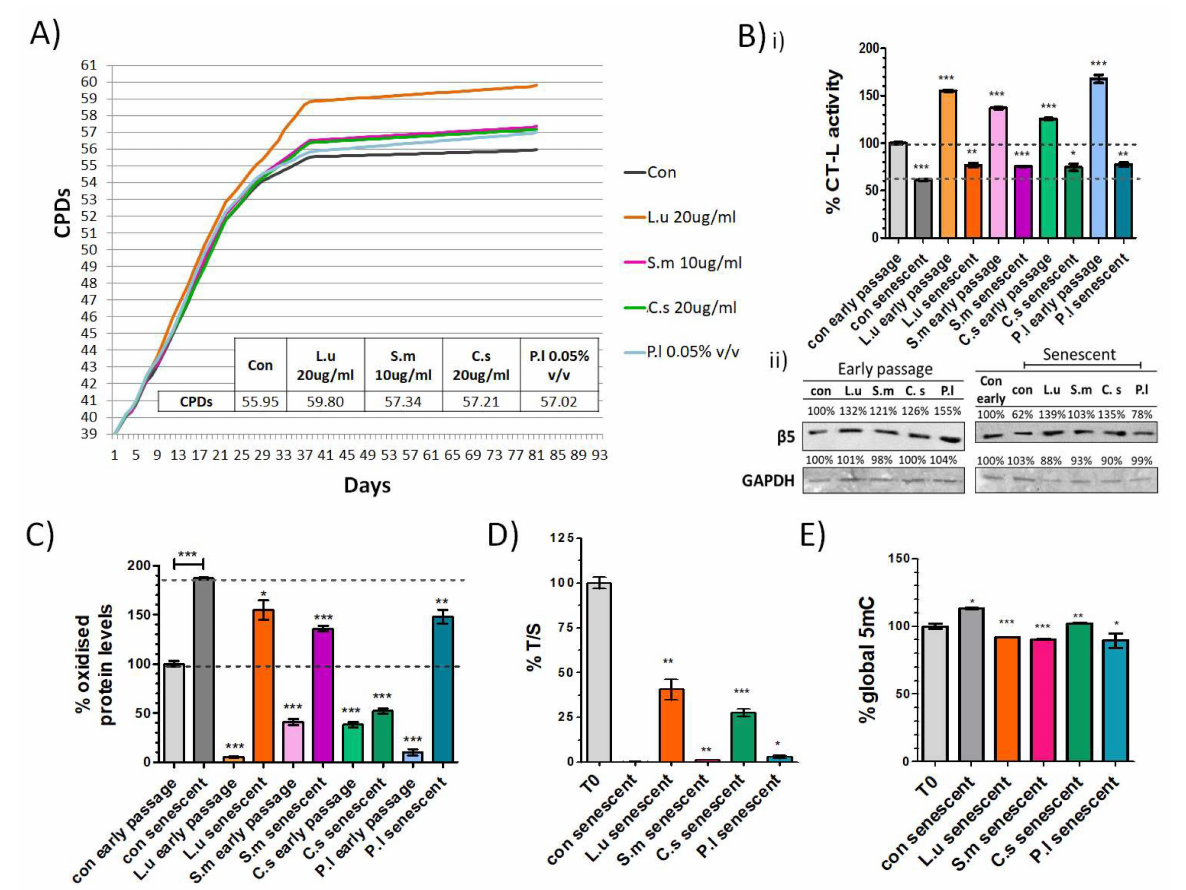
Figure 1. The formulation extends cellular replicative lifespan and reduces the manifestation of aging biomarkers. ( A ) Number of cumulative population doublings (CPDs) of human embryonic fibroblasts continuously treated with the indicated extracts or the solvent (control) as a function of time in culture. ( B ) ( i ) % CT-L activities and ( ii ) immunoblot analysis of the catalytic β 5 proteasome subunit, analysis of ( C ) oxidized protein levels, ( D ) the indicative telomere length T/S ratio and ( E ) global DNA methylation levels in early passage and terminally senescent human fibroblasts grown in media continuously supplemented with the indicated extracts or the solvent (control), throughout their lifespan. The signal in early-passage/T0 control cells was arbitrarily set to 100% in all described assays. GAPDH was used as a control for equal protein loading. ***: p < 0.001, **: p < 0.01, *: p < 0.05. L.u: Linum usitatissimum , S.m: Silybum marianum , S.c: Cynara scolymus